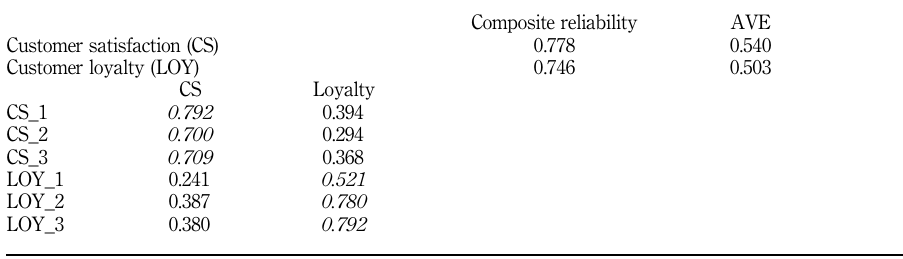
Table III. Assessing the